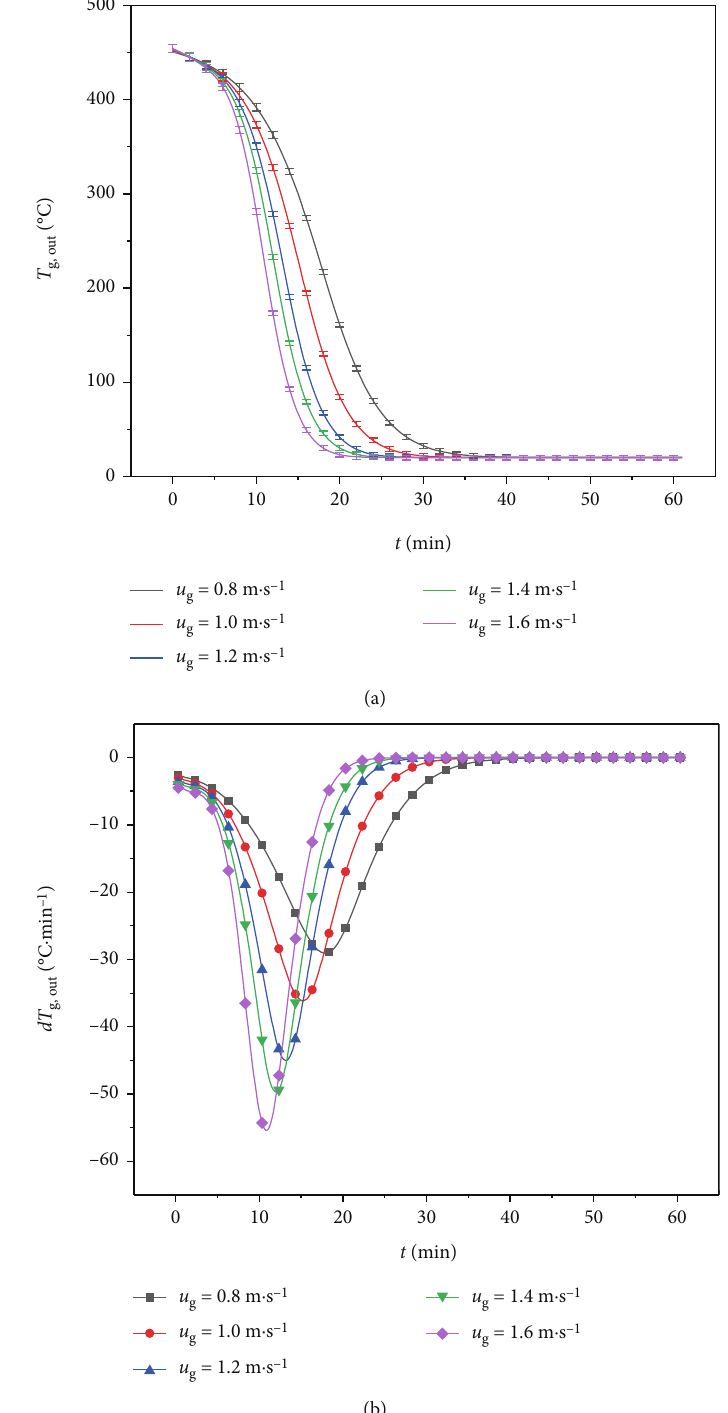
Figure 12: Variations of the gas outlet temperature T under di ff erent gas velocities u